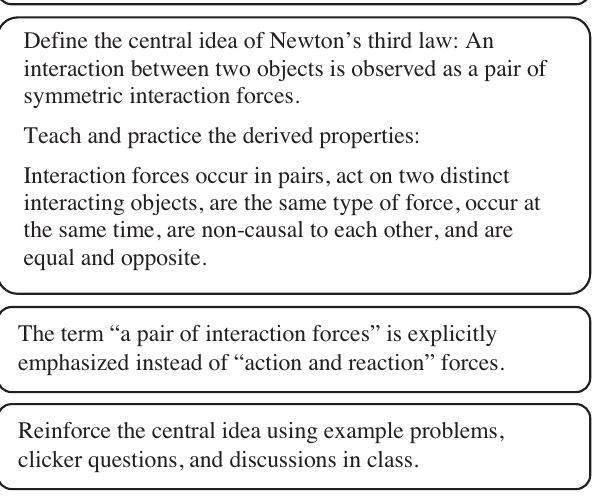
FIG. 3. Steps of the intervention employed in modified N3L